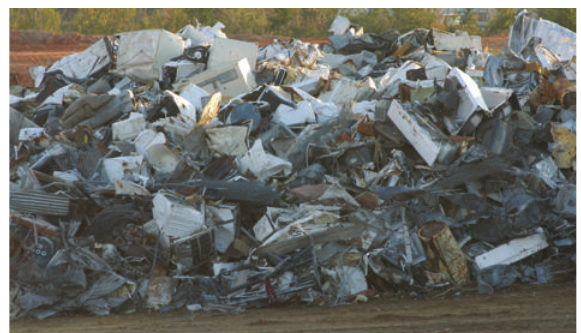
Figure 5: Metal segregated at the Firetower TDSRS in Harrison County, MS.